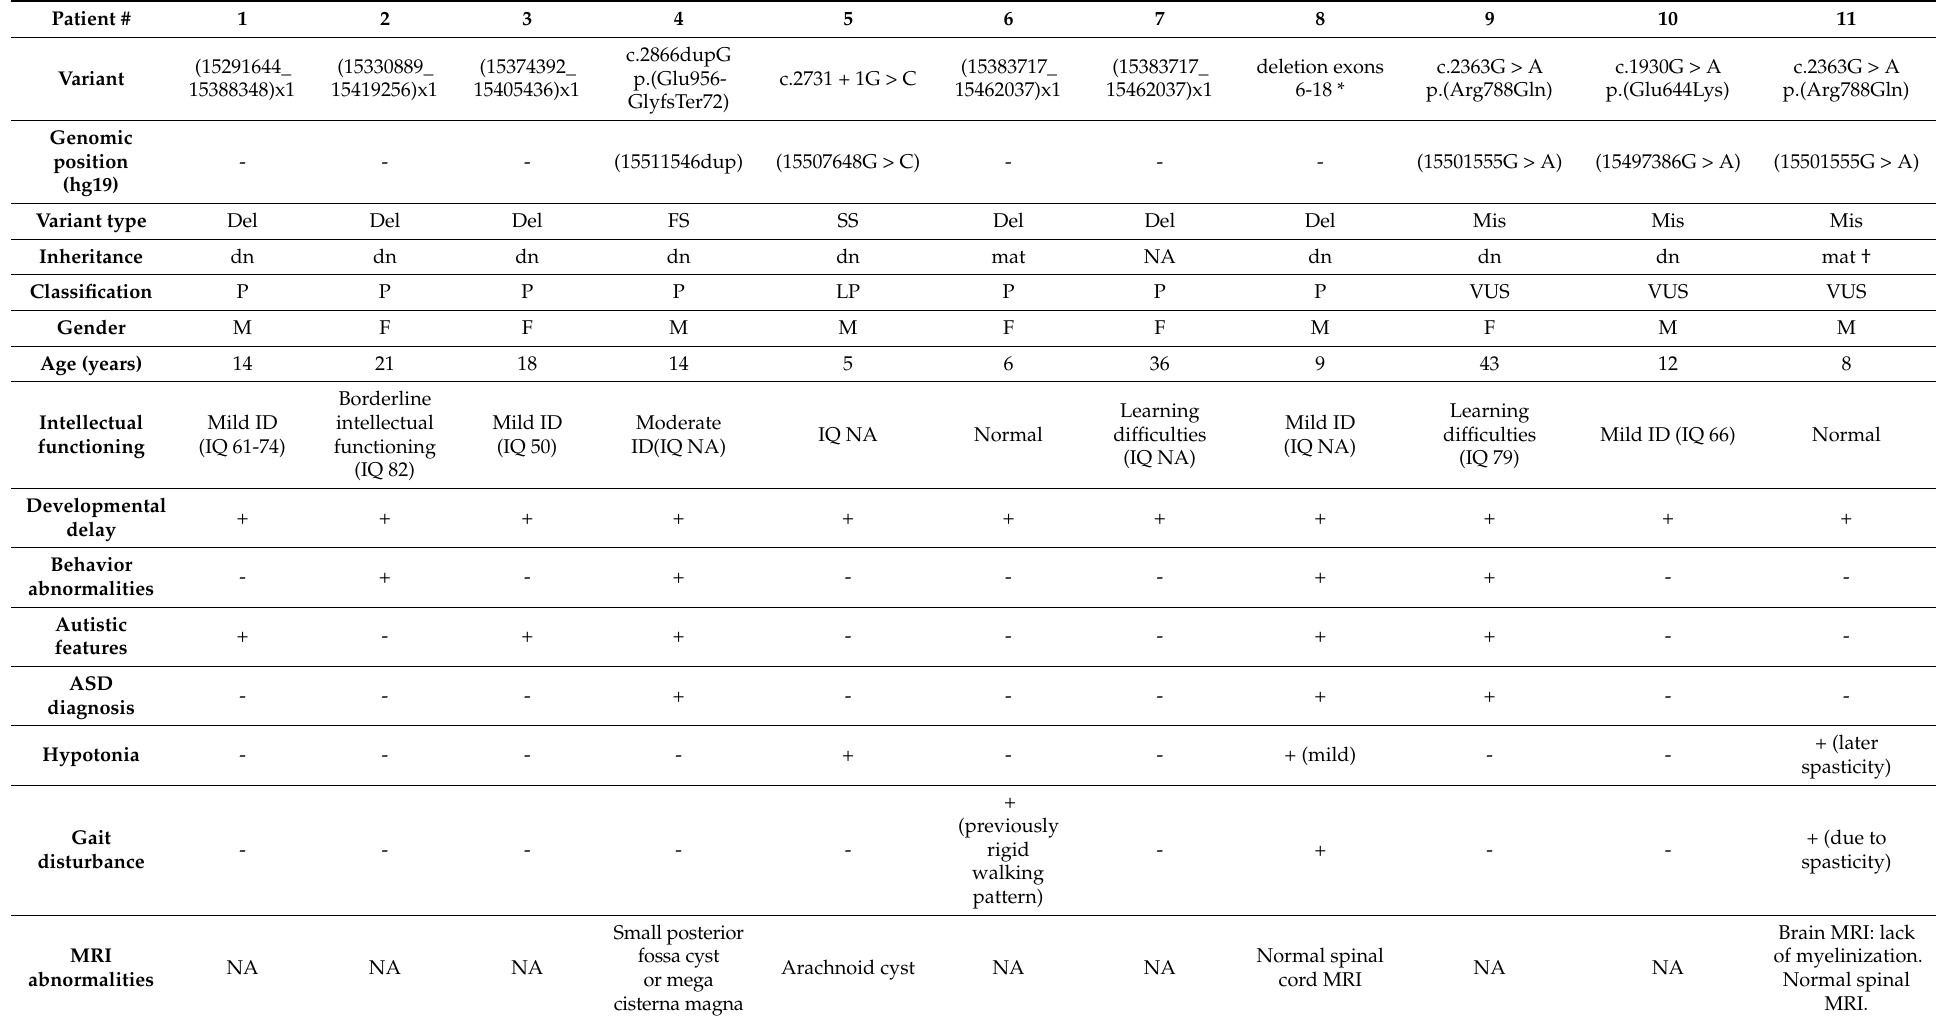
Table 1. Patients’ clinical and genetic characteristics. Patient 7 is the mother of patient 6. Patient 9 and 11 are not related.